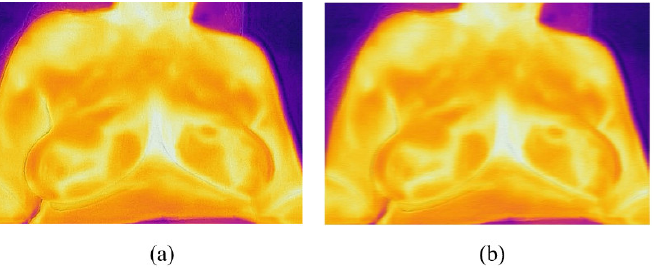
Figure 12. ( a ) Original Thermal Image from Shiraz Medical Center for Breast Cancer & ( b ) Shaken Thermal Image.